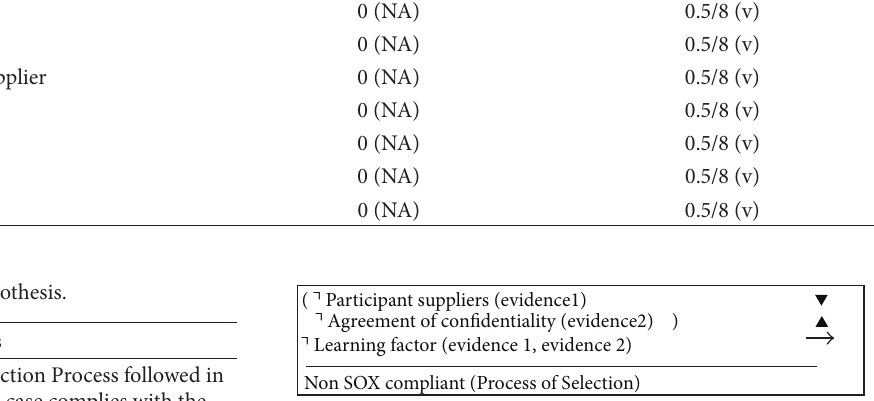
Figure 3: Complementary